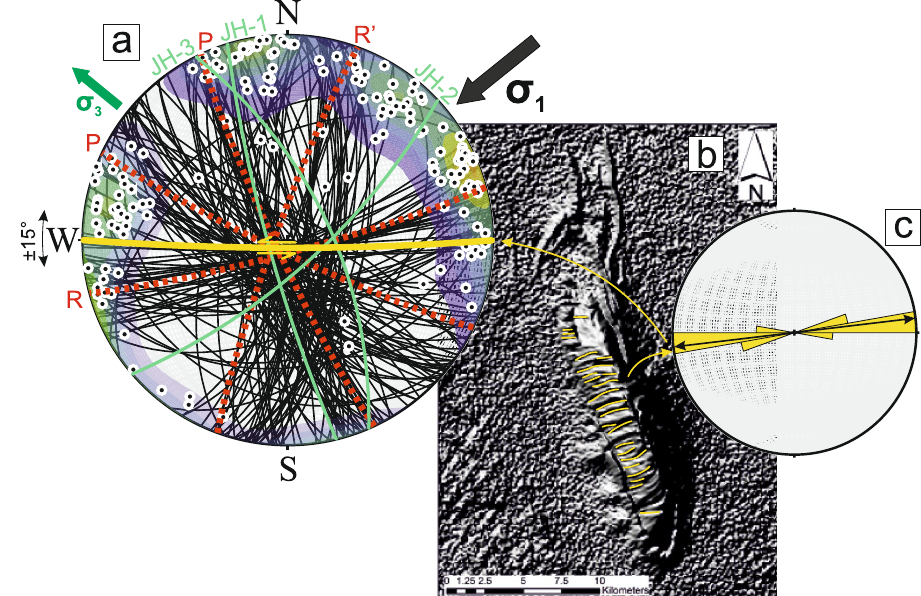
Figure 2. ( a ) Lower-hemisphere equal-area stereonet projection of shear planes with more than 1 mm of carbonate cement infill (N = 166, black lines). Red dashed great circles represent a schematic Riedel-type model constructed using the major structural trends identified by stereographic projection of these shear planes. Black and green arrows indicate the possible orientation of the paleo-maximum (σ 1 ) and minimum (σ 3 ) horizontal stresses. The yellow great circle indicates the likely orientation of the major strike-slip shear planes based on the orientation of the major drainage lineaments of the Jabal Hafeer anticline, green great cricles represent the orientation of the veins where samples have been collected. ( b ) Hillshade imaging of Jabal Hafeet based on the SRTM digital elevation model of the area showing the orientation of the drainage pattern (yellow lineaments). ( c ) Rose diagram of the orientation of the drainage patterns showing the likely orientation of major strike-slip structures within the Jabal Hafeet